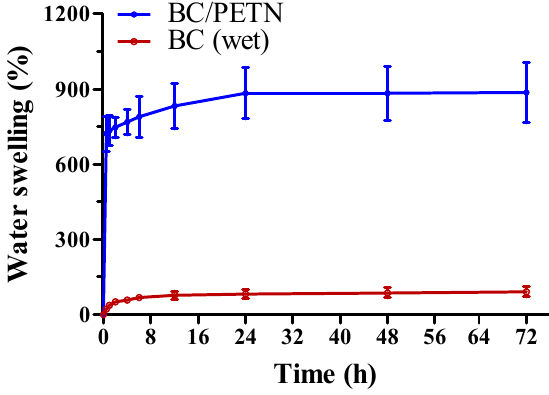
Figure 5. Water swelling ratio of the BC/PETN and BC (wet) membranes.